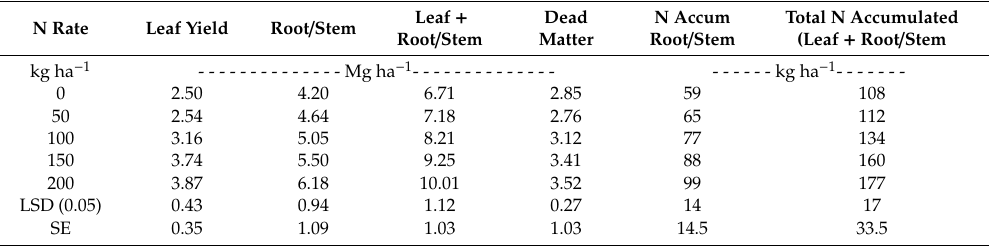
Table 4. Leaf, root / stem, leaf + root / stem, and dead matter yield, N accumulation in the root / stem and total nitrogen (N) accumulated in (leaf + root / stem) response to N rates averaged across sulfur (S)rates, species, and